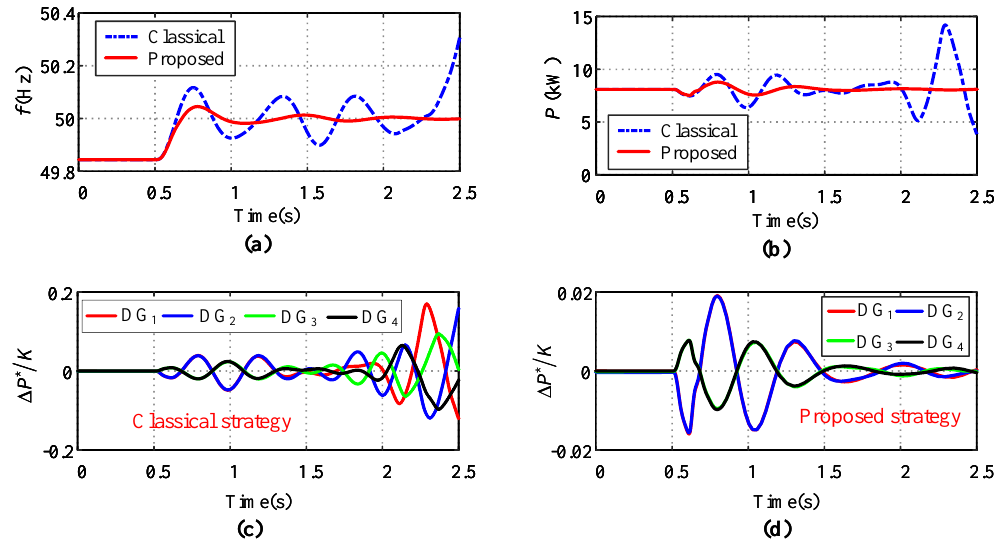
Figure 9. Comparison of delay robustness of the proposed strategy and that of the classical feedback linearization strategy when τ = 1 s: ( a ) frequency of DG1; ( b ) output active power of DG1; ( c ) ∆ P ∗ of the feedback linearization strategy; ( d ) ∆ P ∗